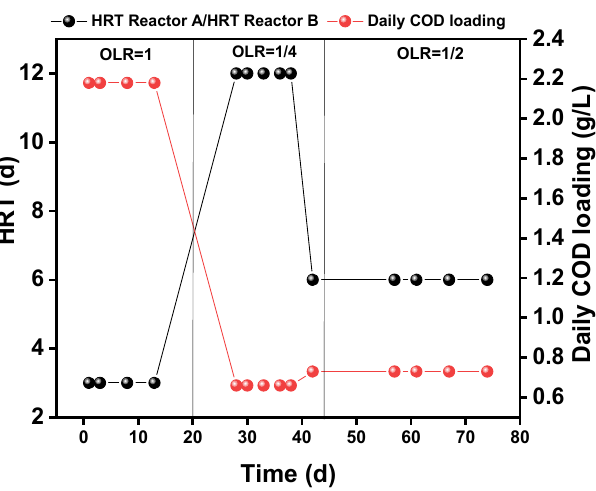
Figure 2. Operational scheme for the laboratory scale reactors. ORL: organic loading rate.